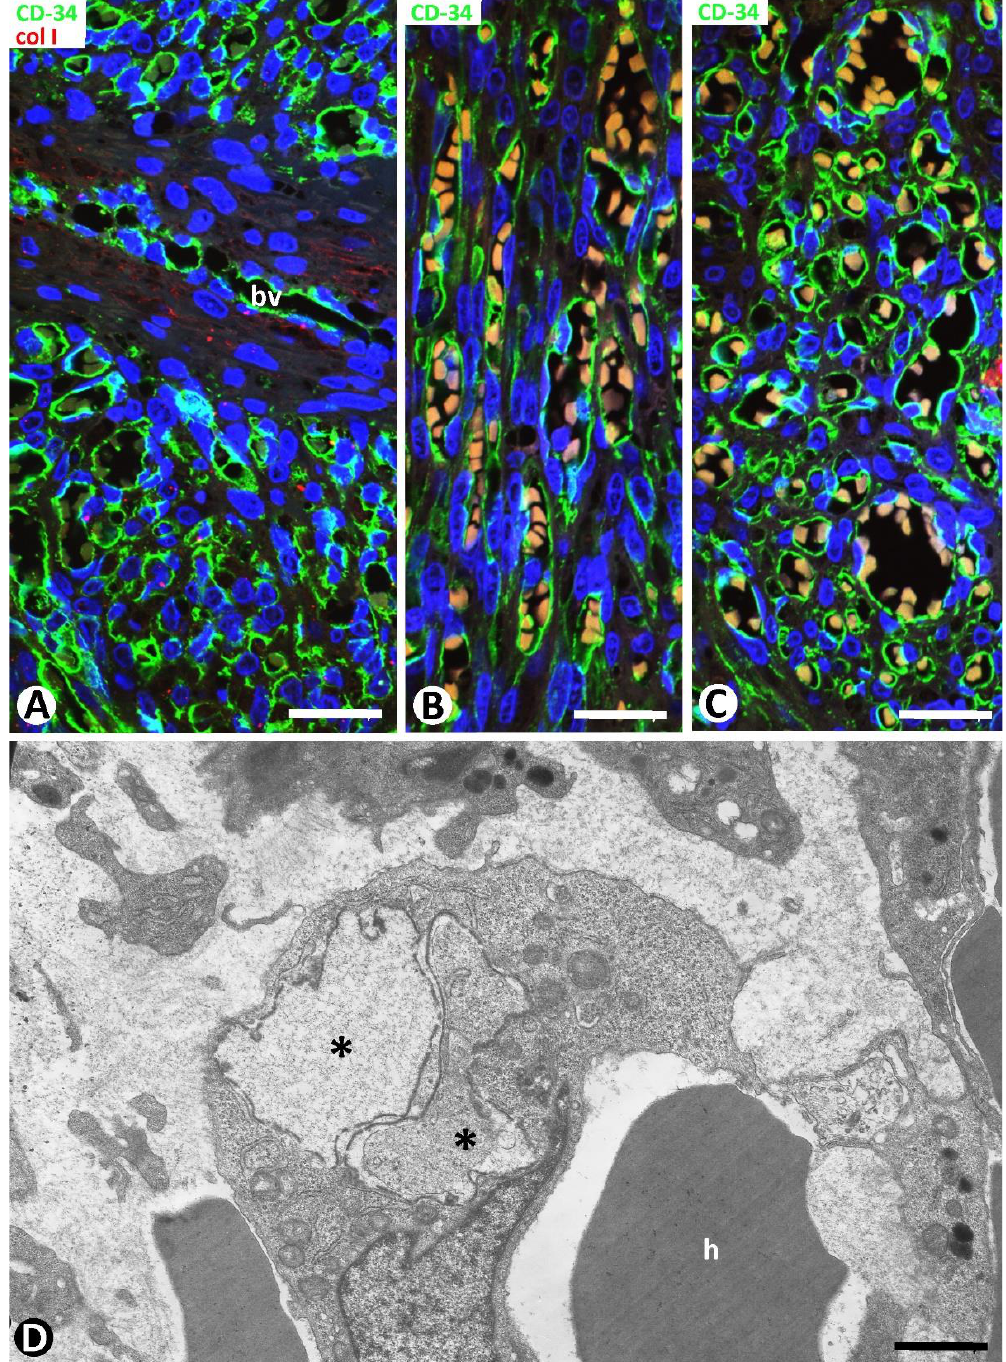
Figure 13. ( A – C ): Numerous type 2 neovessels (CD34+ ECs, green) and scarce and weak expression of collagen I (red) are observed in the nodular stage of KS. Note in ( A ) the interposed pre-existing blood vessel (bv), and in ( B , C ) one or several red blood cells in the lumen of different size neovessels, in longitudinal and transversal sections. ( D ): Ultrastructural image of a neovessel with an intralu- minal red blood cell (h) and an EC showing intracytoplasmic degraded red blood cells (asterisks). ( A ): Double immunofluorescence for CD34 (green) and collagen I (red). ( B , C ). Immunofluores- cence for CD34. DAPI counterstain ( D ): Ultrathin section. Uranyl acetate and lead citrate. Bar: ( A – C ): 25 µ m; ( D ): 1.5 µ